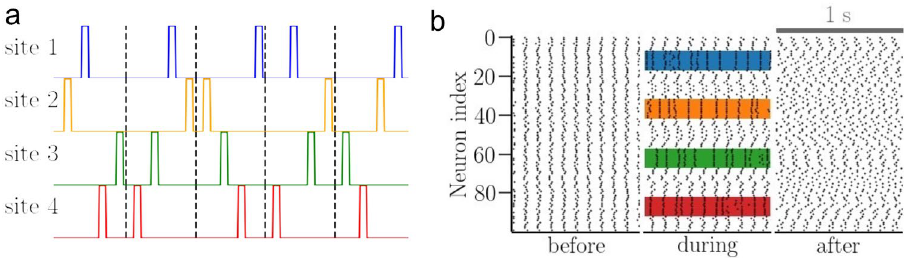
Figure 4. Rapidly varying sequences (RVS) CR stimulus and its effect on a synchronized network of identical oscillators. ( a ) Five cycles of RVS CR stimulus, separated by vertical dashed lines, delivered at N c = 4 sites (color coded). ( b ) Raster plots before, during, and 10 h after stimulation. Stimulation sites are indicated by colored patches. Parameters are a = 0.3 , γ = 3 ; stimulus: I s = 400 , duration = 70